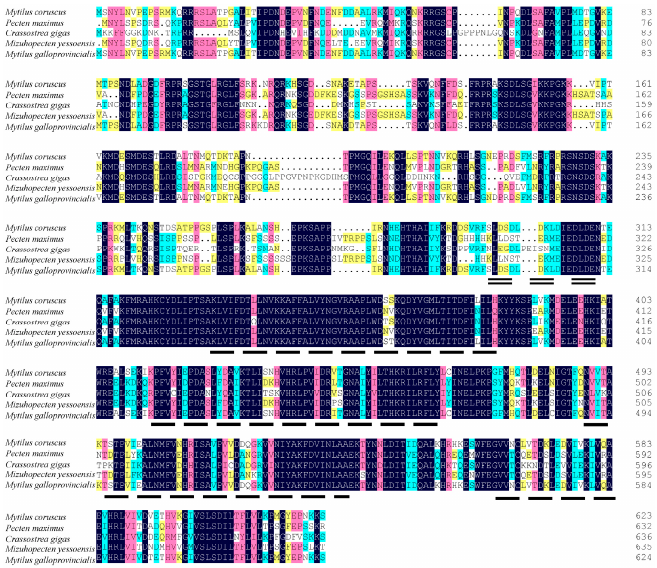
Figure 7. Multiple sequence alignment of McAMPK γ with other mollusks. The double-dashed line area represents the CBS domain; the long-dashed line area represents the low complexity. The accession number of the AMPK γ sequence used: Pecten maximus (XP_033762248.1), Crassostrea gigas (XP_034310765.1), Mizuhopecten yessoensis (XP_021369706.1), and Mytilus galloprovincialis (VDI78590.1).